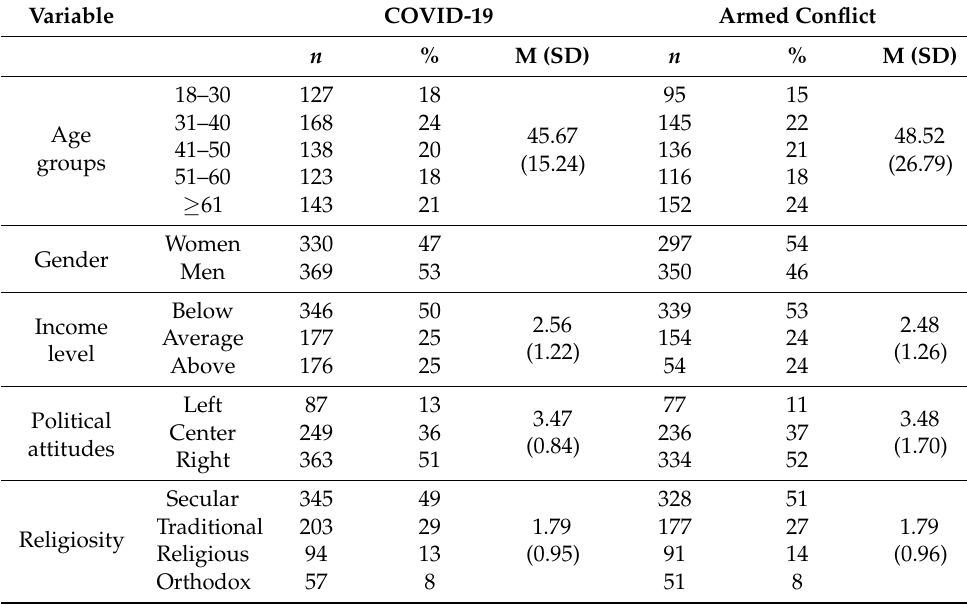
Table 1. Demographic characteristics of the two investigated samples: COVID-19 (699) and Gaza 21 May conflict